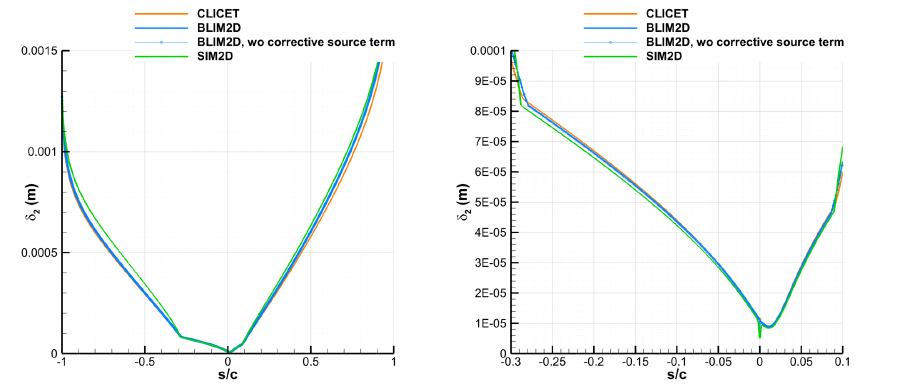
Figure A7. Solution produced by CLICET, SIM2D, and BLIM2D for the momentum thickness δ 2 in Case 1 of Table A1. ( Left ): whole airfoil. ( Right ): laminar